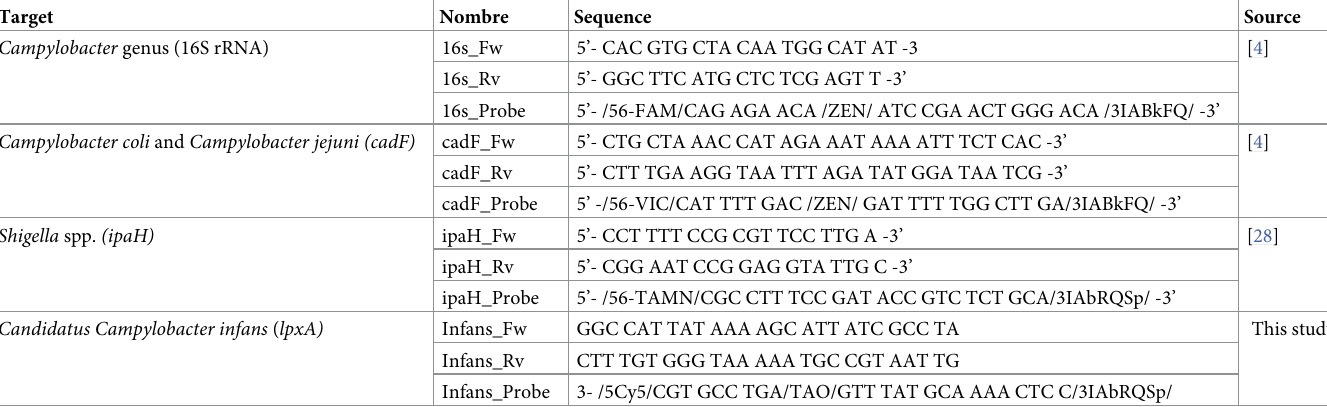
Table 1. Primers and probes for the detection of Campylobacter spp., Campylobacter jejuni/coli , candidatus Campylobacter infans and Shigella spp.